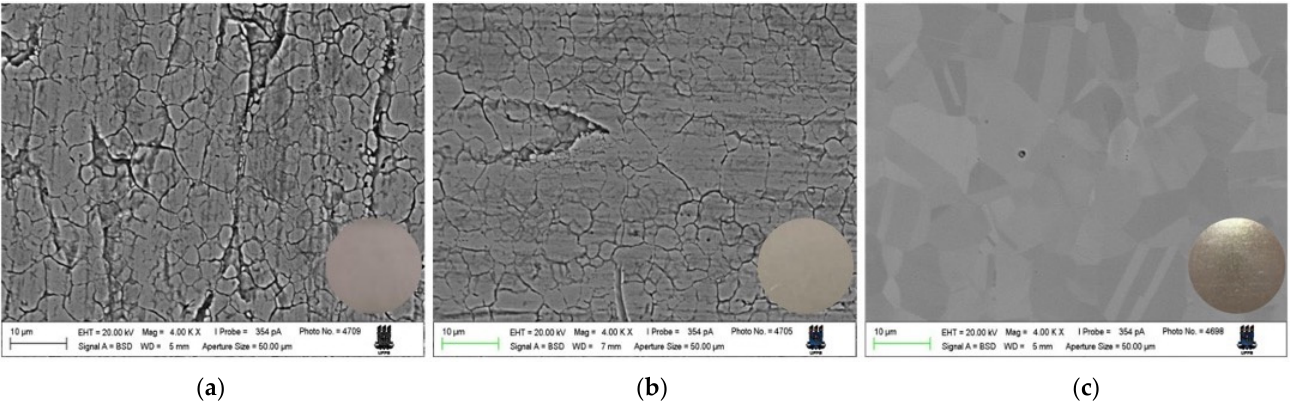
Figure 4. Superficial micrographs of DC ( a ), AT ( b ), and EP ( c ) substrates obtained by scanning electron microscopy. Magnifications: 4000×. electron microscopy. Magnifications: 4000 ×